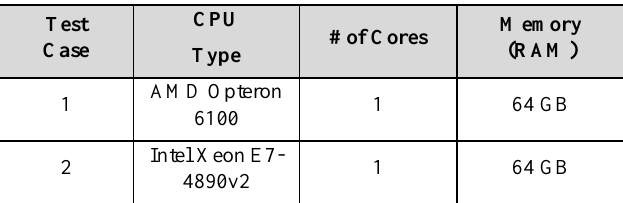
Table 1: Phase 1 Hardware Configuration